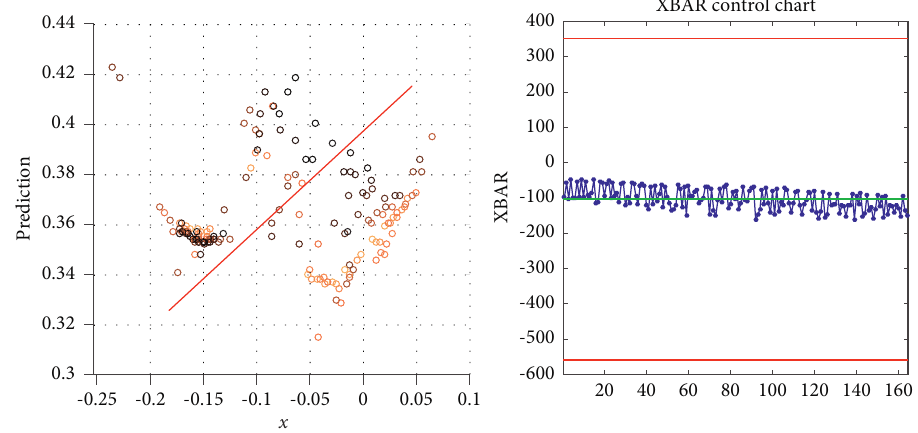
Figure 4: Prediction.